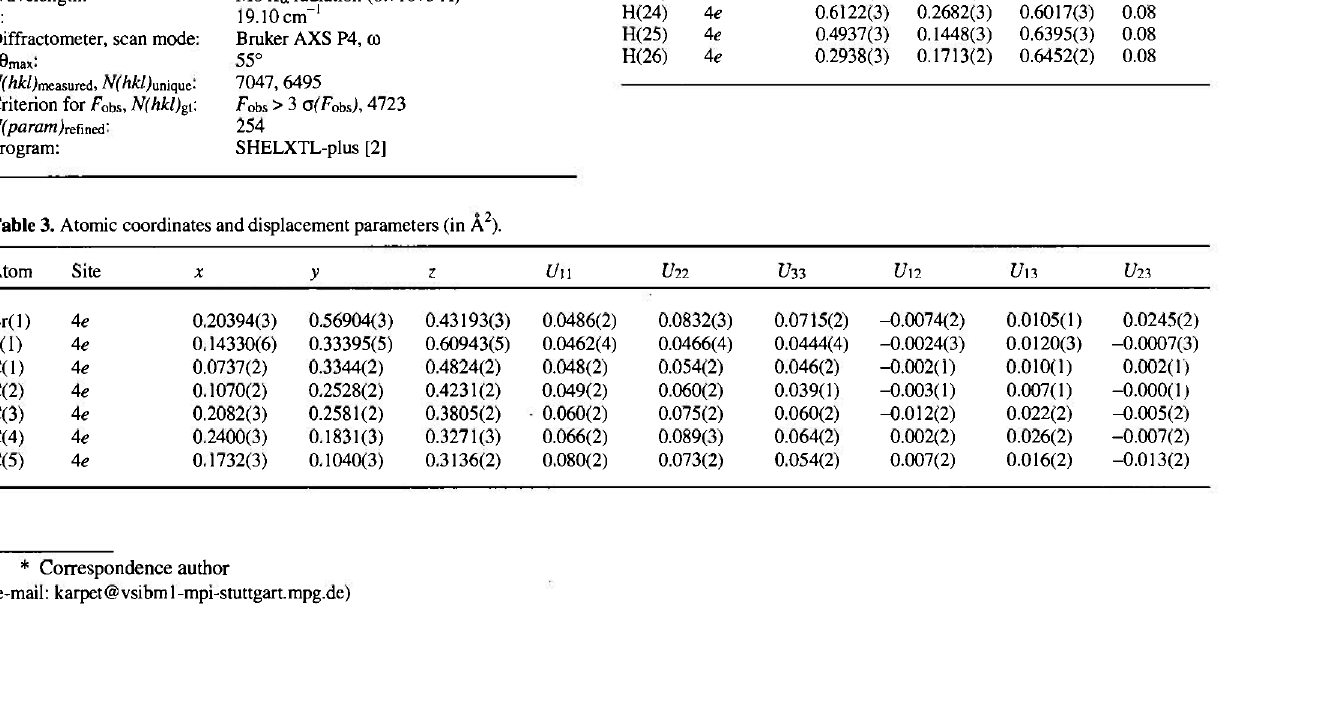
Table 1. Data collection and handling.